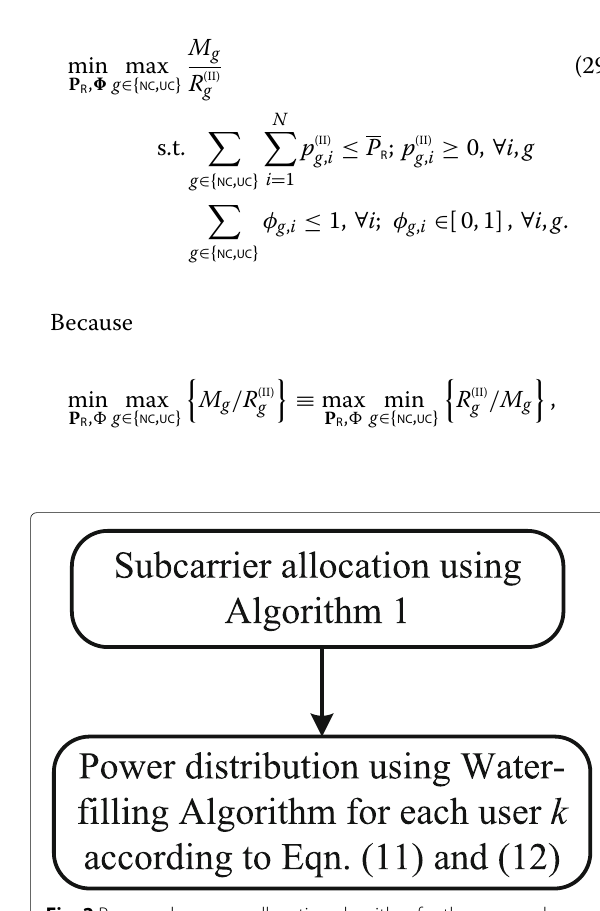
Fig. 2 Proposed resource allocation algorithm for the source phase